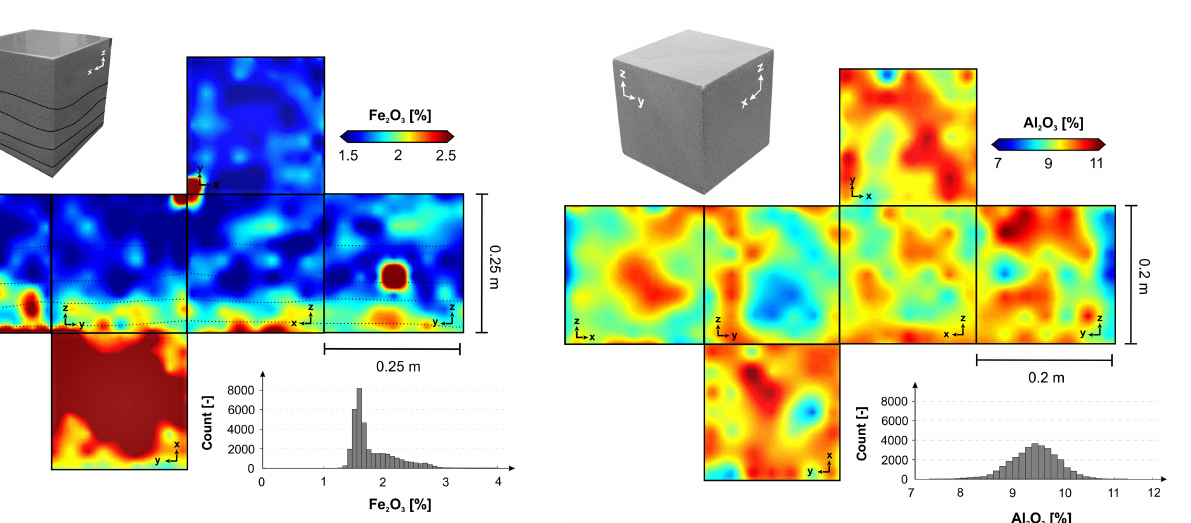
Figure 13. Spatial distribution of the mass fraction of Al 2 O 3 mod- eled with a simple kriging interpolation. The pattern is decou- pled from primary sedimentary structures and shows a network-like